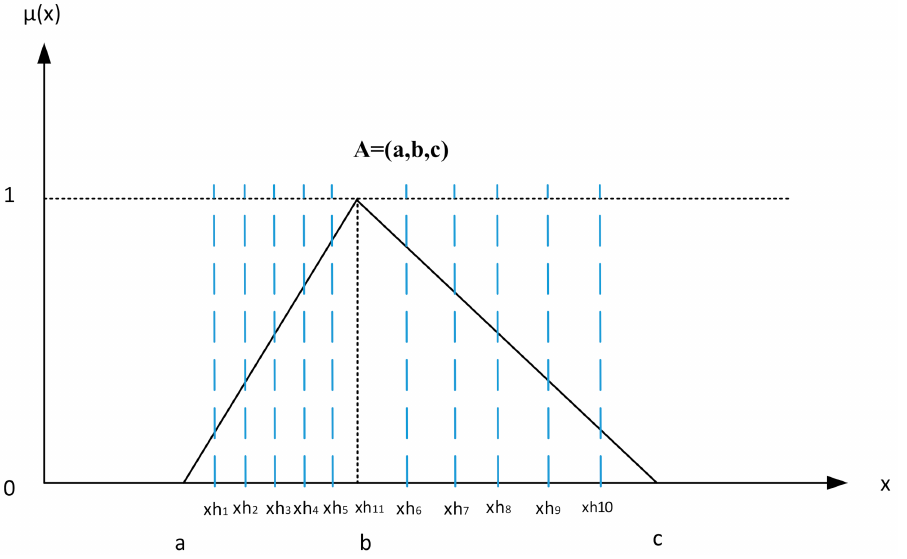
Figure 1. Fuzzy triangular number with